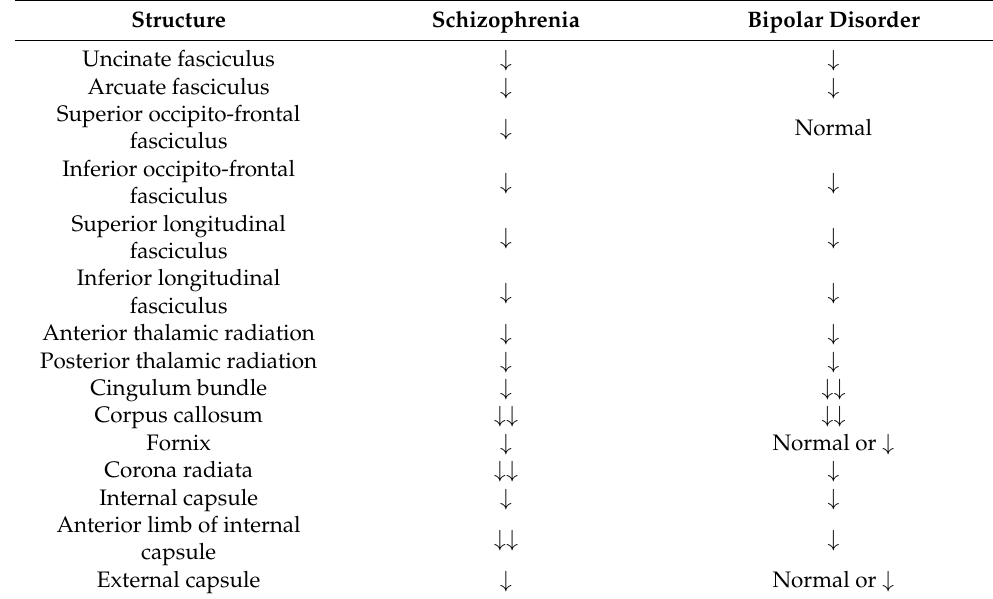
Table 2. Fractional anisotropy changes in schizophrenia and bipolar